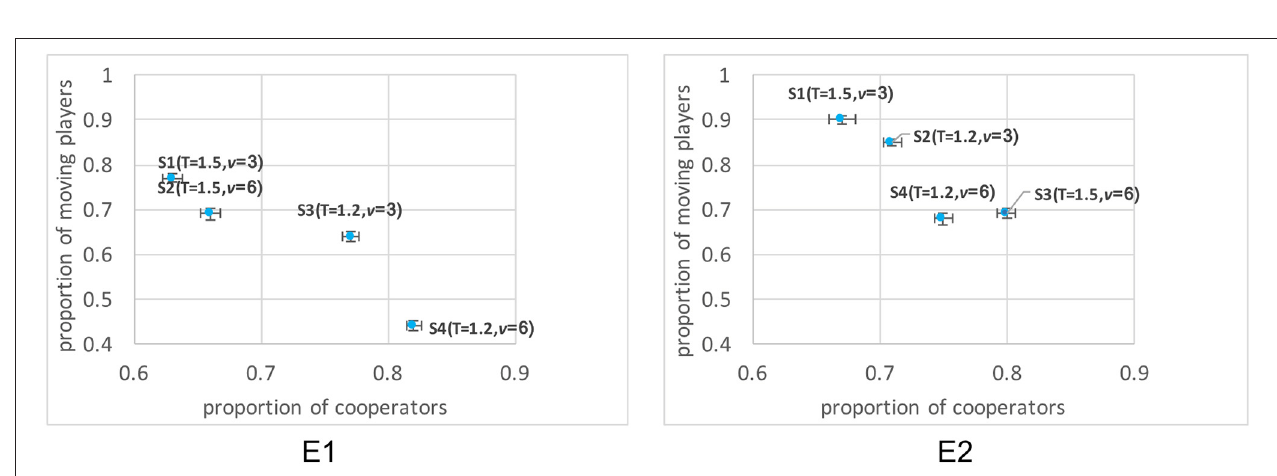
FIGURE 3 | The average proportion of cooperators and moving players in each session. The error bar represents 95% confidence interval.